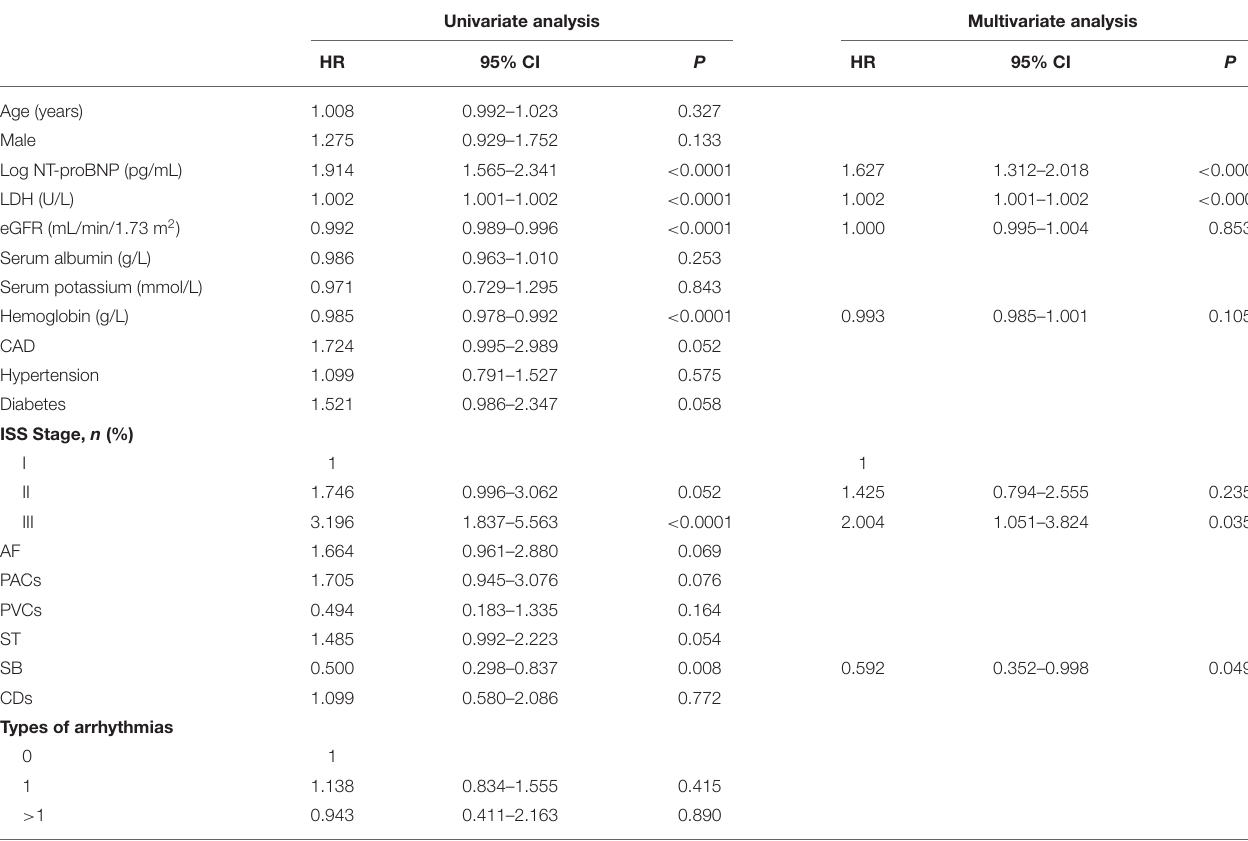
TABLE 3 | Univariate and multivariate Cox regression analysis for all-cause mortality. Univariate analysis Multivariate